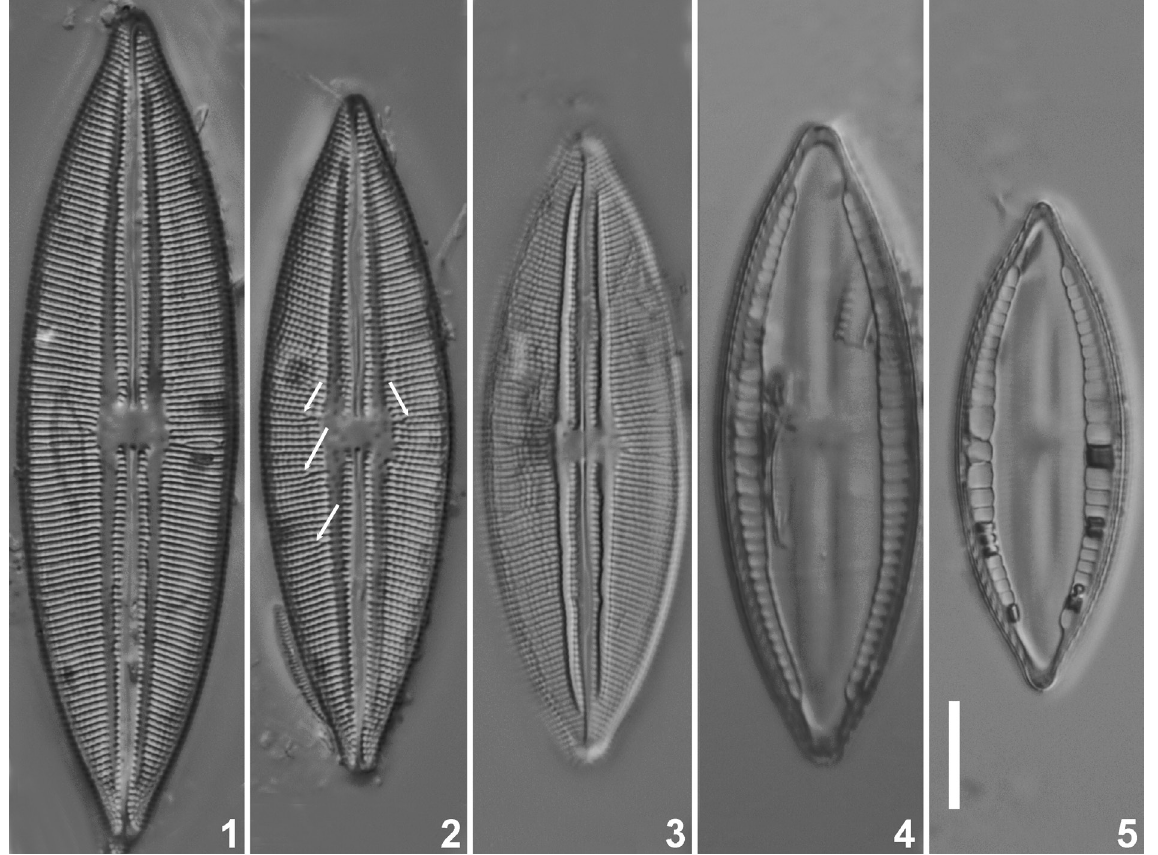
Figs 1–5. Mastogloia braunii Grunow. Light micrographs (LM) of valves from the type population ( Grunow 23583 – capsule 0645 , Vienna, Austria). 1–3 . LM views of 3 valves showing variation in valve size and shape. The arrows in Fig. 2 indicate shortened striae near the central area. 3–4 . Same valve taken at different foci. 4–5 . LM views of the partectal ring with the partecta. Scale bar: 10